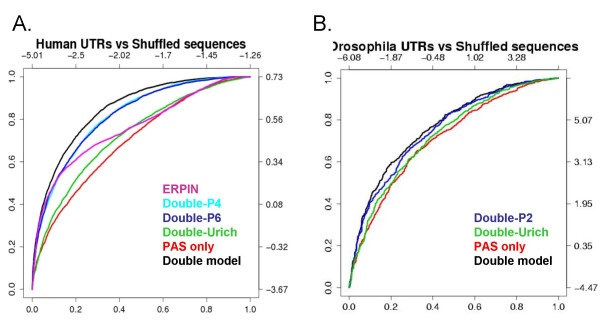
The double model including the deduced DSE matrices improves the discrimination of real 3'UTRs from control sequences. ROC curves showing comparison of best scores (Forward decoding). True positive rate was computed for 3'880 3'000 bp long human sequences (A) and 840 600 bp long Drosophila sequences (B). False positive rate was computed on the test set sequences randomized in 100 bases windows. A-B: Double model (black curve) is more specific than PAS-only model (red), and that ERPIN 3.1 predictions. The DSE matrix included in the double model allows better recognition than a U-rich 25 nt matrix (green) or modified versions of the DSE, where position 4 or 6 (human) or 2 (Drosophila) have been replaced with background nucleotide frequency.